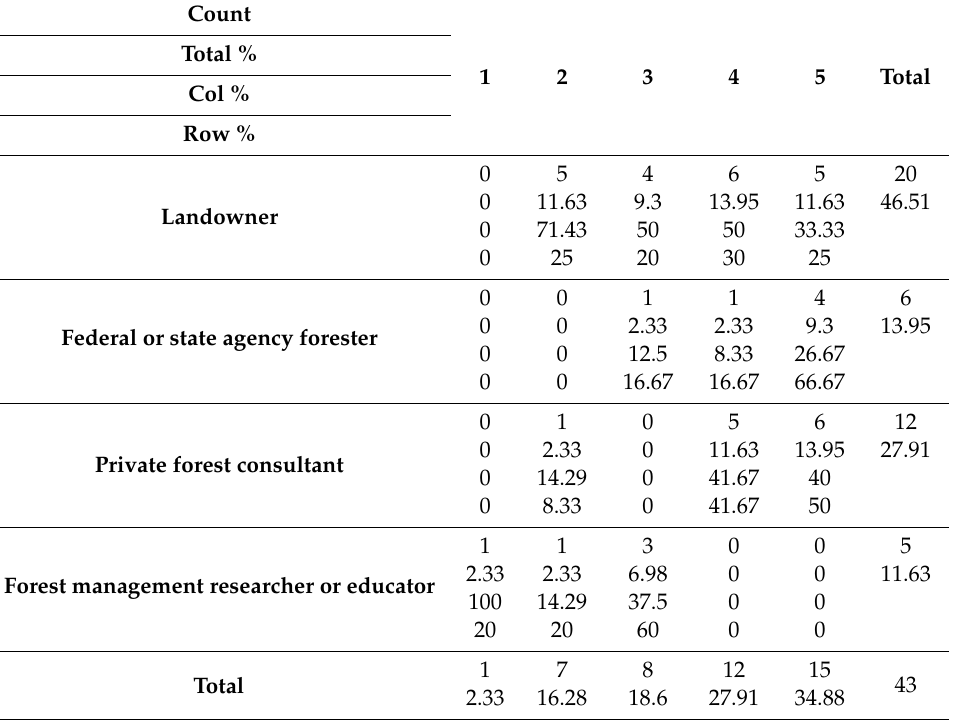
Table 6. Contingency analysis of “How would you rate your level of experience?” Count 1